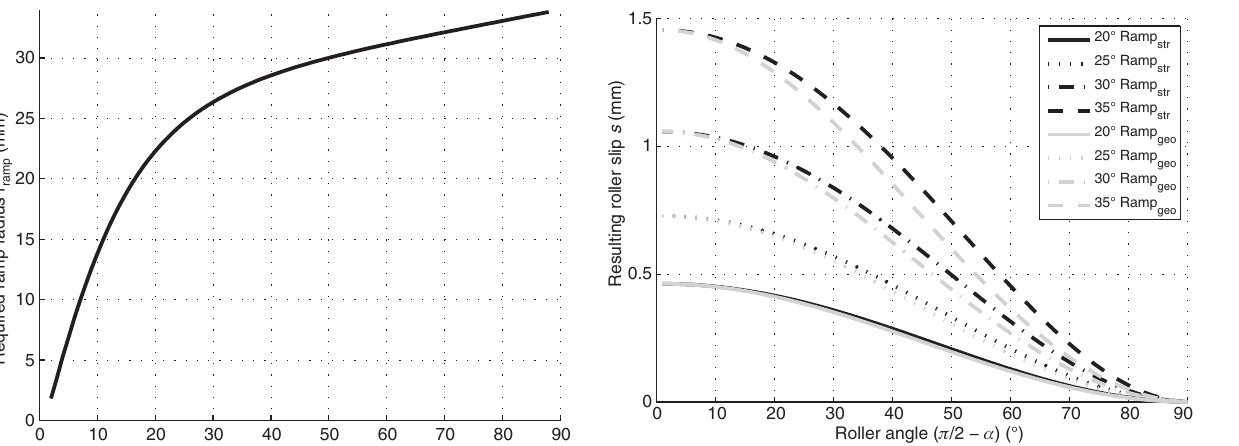
Figure 15 Analytical results for required bottom ramp radius at 90 ° path angle.